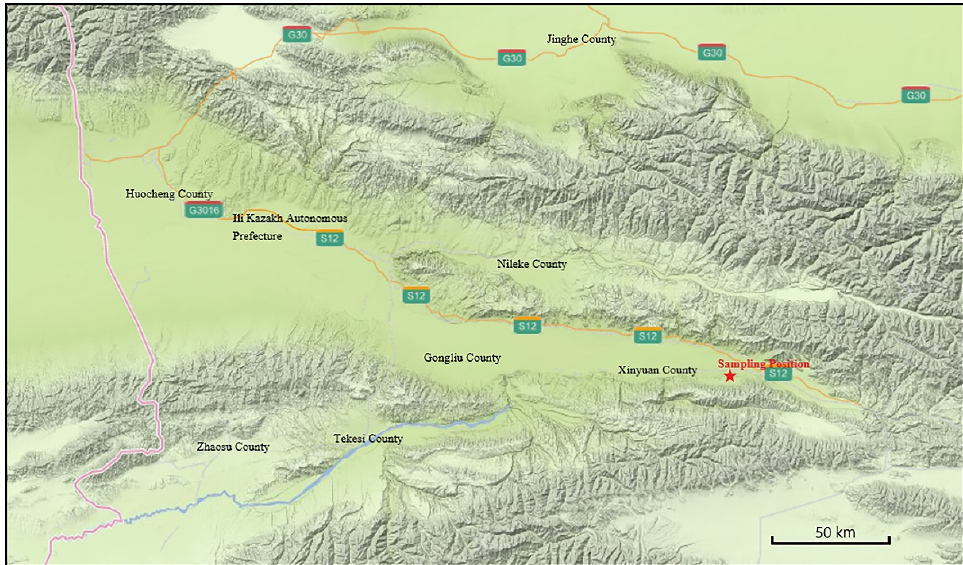
Figure 1. Illustration of sampling positions of Yili loess.